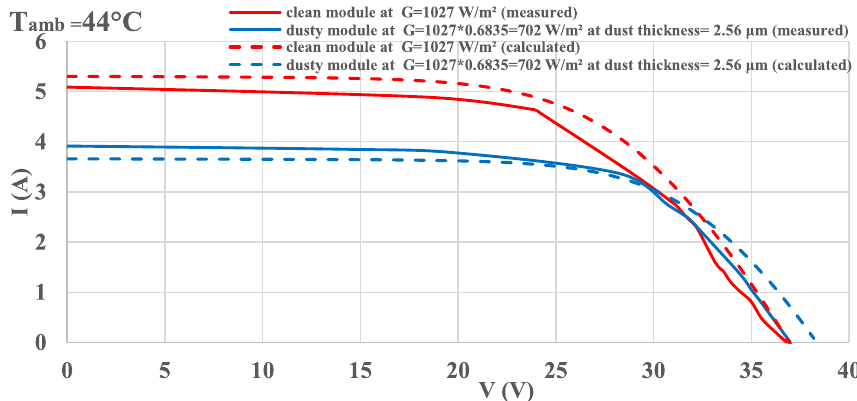
Fig. 7 Measured and calculated current–voltage characteristic curves of dusty and clean modules at ambient incident radiation of 1027 W/m 2 http:// enerw in. com/ enerw in/